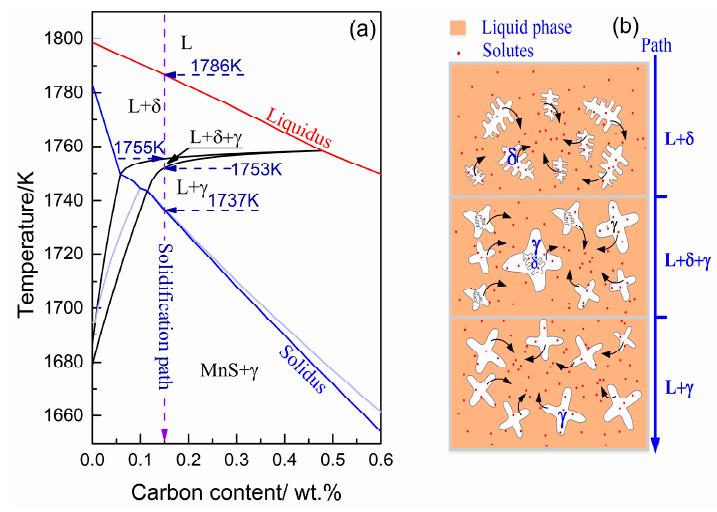
Figure 3. ( a ) Solidification path of steel Q345 and ( b ) the solutes redistribution process.